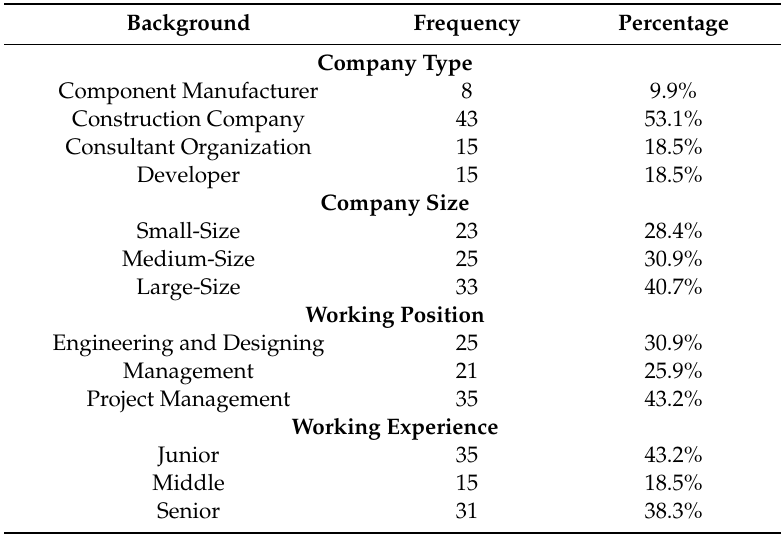
Figure 2. Experience with industrialized construction ( a ) levels of prefabrication have been utilized ( b ) project types that have used prefabrication techniques ( c ) locations of industrialized projects. Respondents are from different types of companies, in which more than half are from the construction company (Table 3). The annual revenue of respondents’ organization is used to serve as